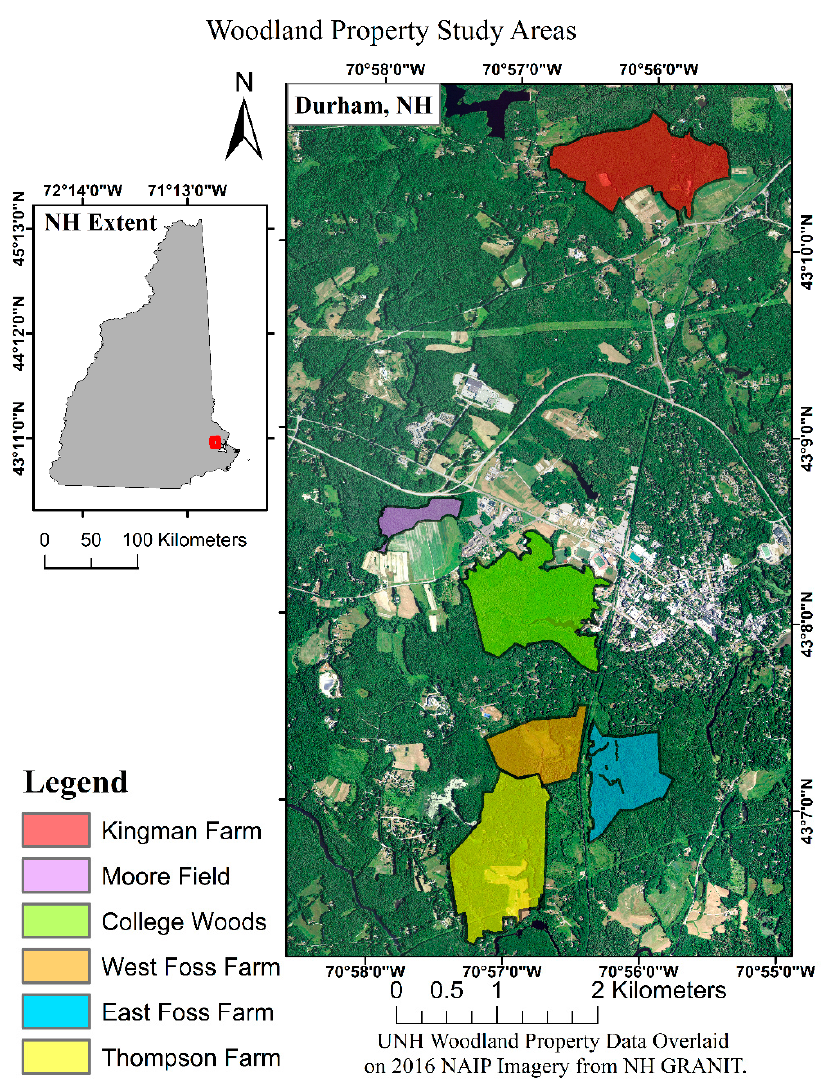
Figure 1. Woodland property boundaries for the six study areas. From North to South (with total area): Kingman Farm (135.17 ha), Moore Field (47.76 ha), College Woods (101.17 ha), West Foss Farm (52.27 ha), East Foss Farm (62.32 ha), and Thompson Farm (118.17 ha).